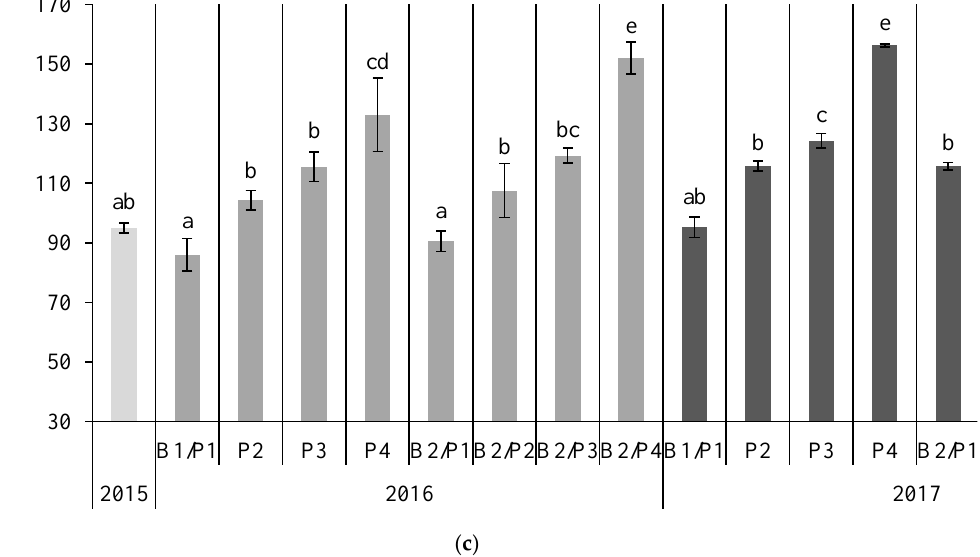
Figure 2. Contents of absorbable forms of phosphorus P 2 O 5 ( a ), potassium K 2 O ( b ), and magnesium Mg ( c ) in the soil before the experiment (2015) and after the first and second year of cultivation, depending on the fertiliser used. Differences between average values marked with the same Arabic letters are not statistically significant at the level of α ≤ 0.05 according to the Bonferroni test.